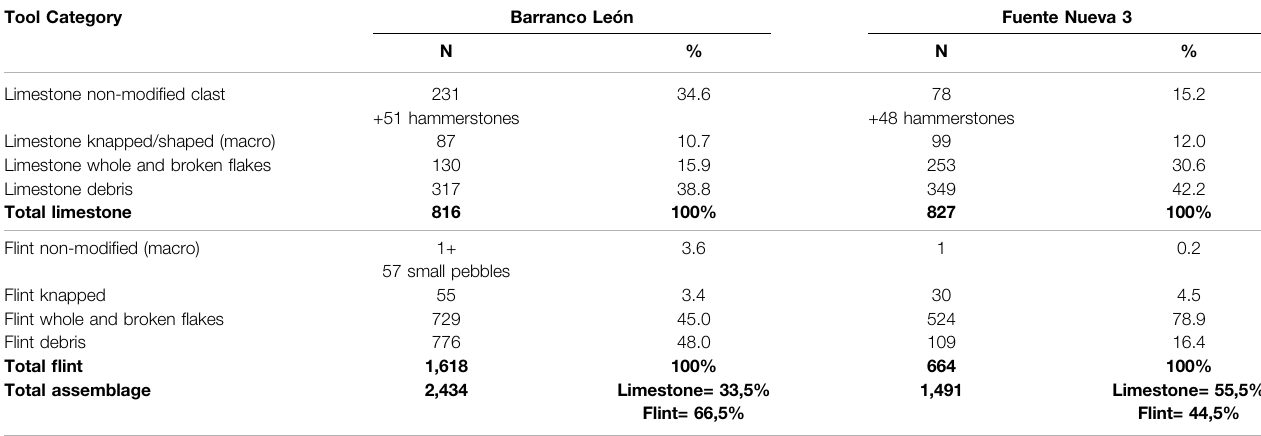
Bold letters in table indicate